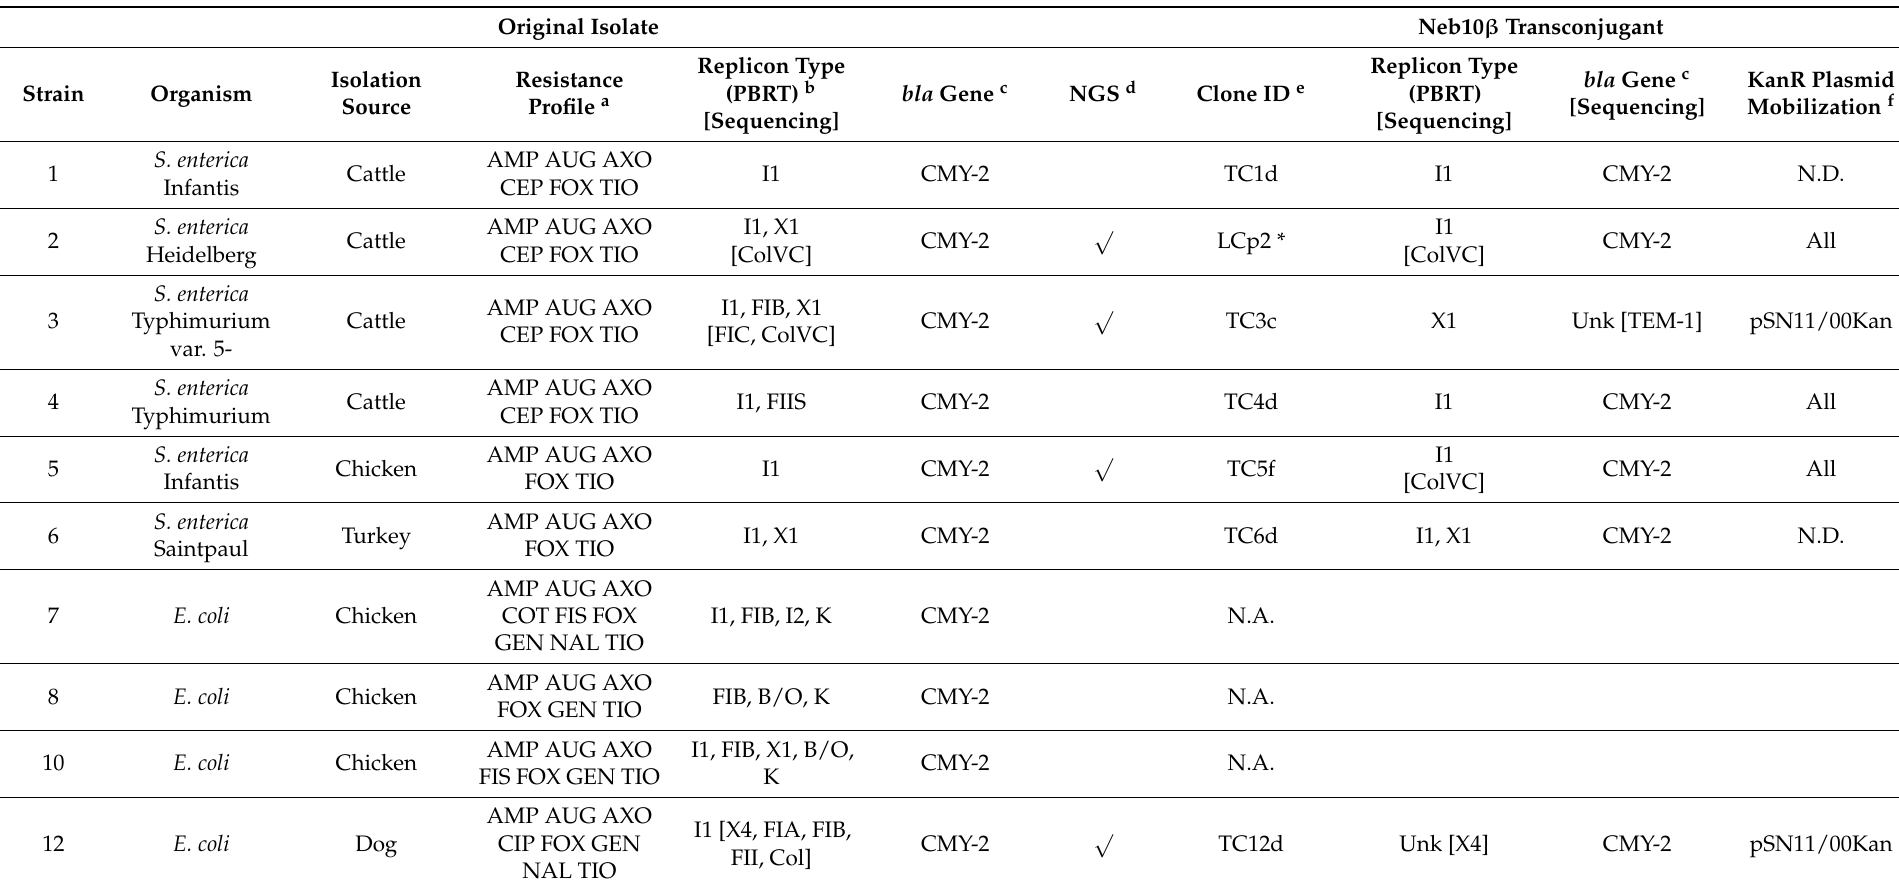
Table 1. Strain characterization: antibiogram, plasmid replicon typing, and β -lactamase